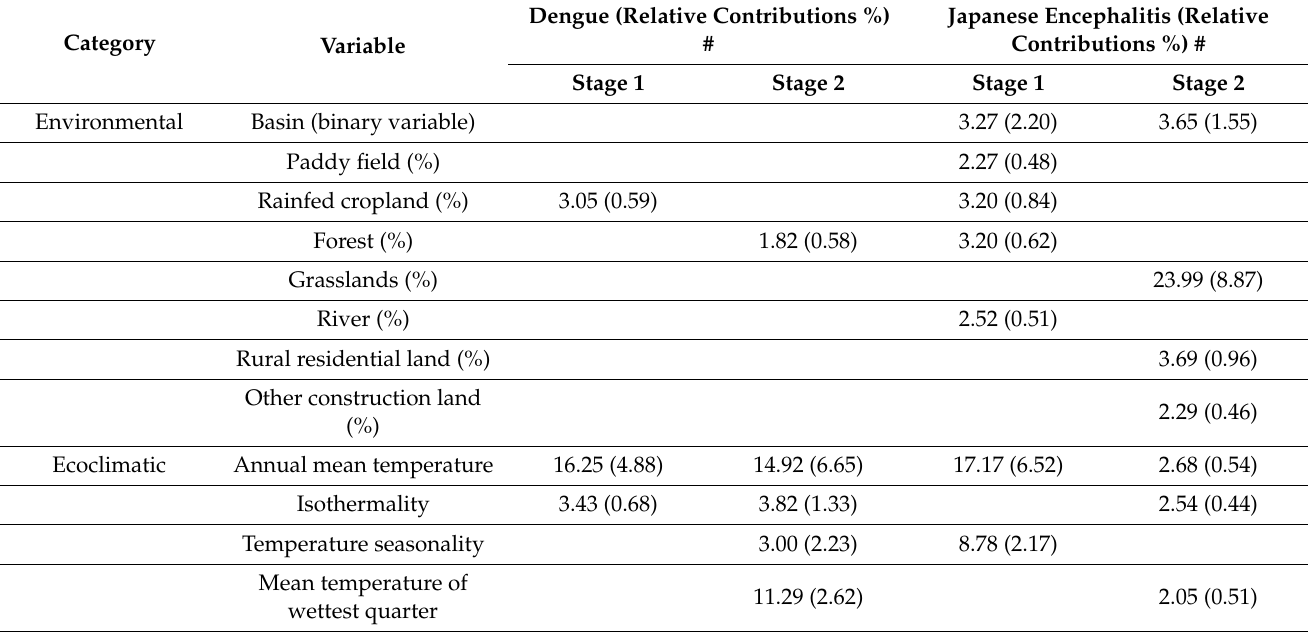
Table 2. Mean (standard deviation) relative contributions of major factors to the spatial distributions of dengue and JE, estimated by two-stage GBRT